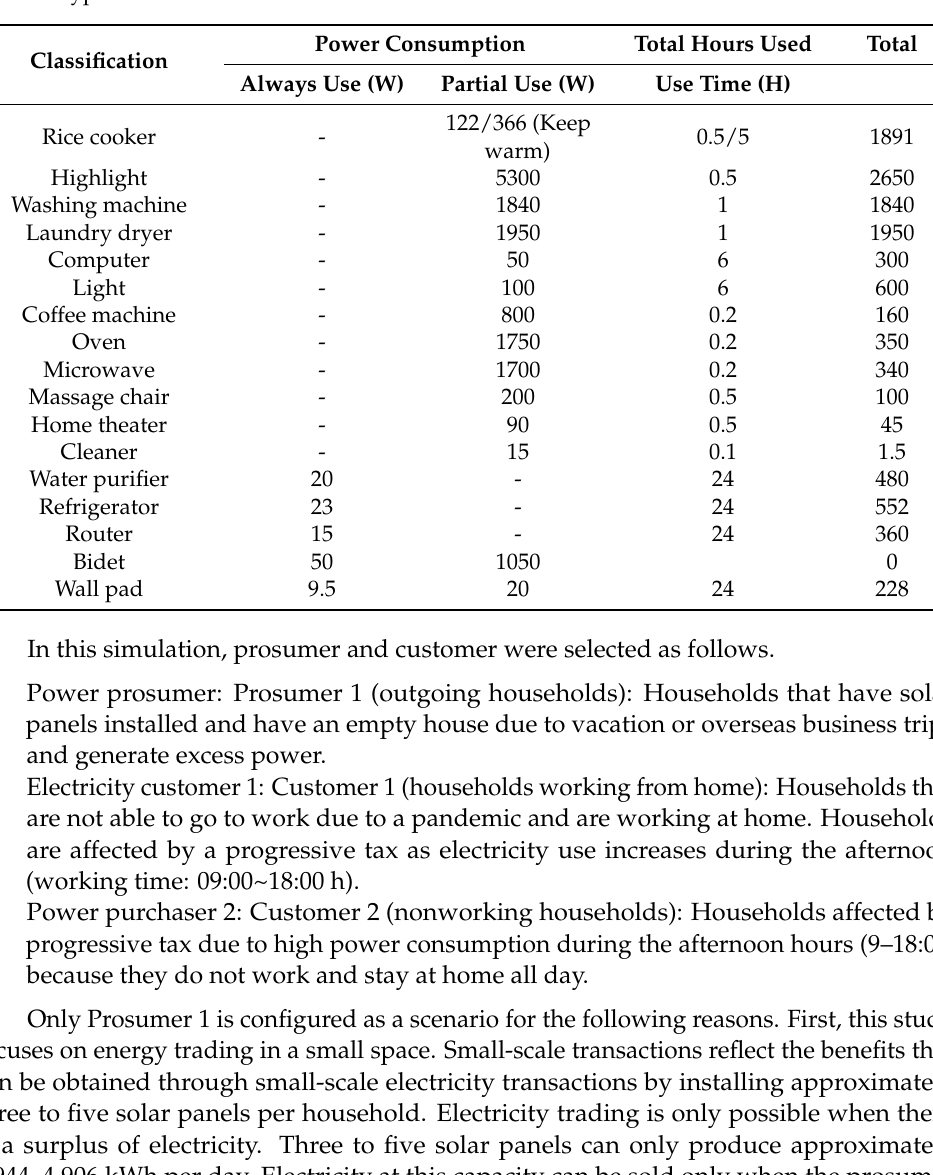
Table 2. Typical home devices used in one